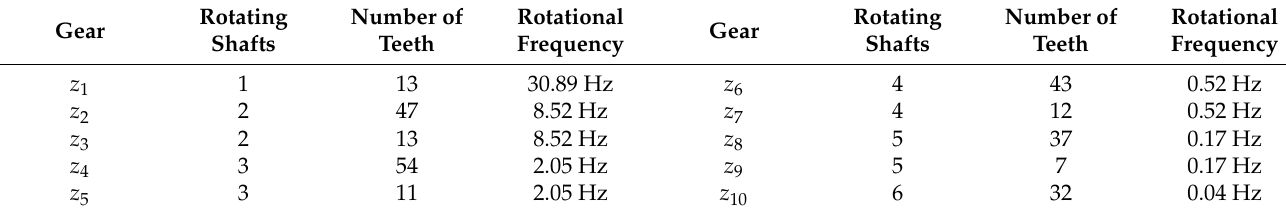
Figure 1. The structure of the grille controller. Table 1. The number of teeth and rotation frequency of each gear.